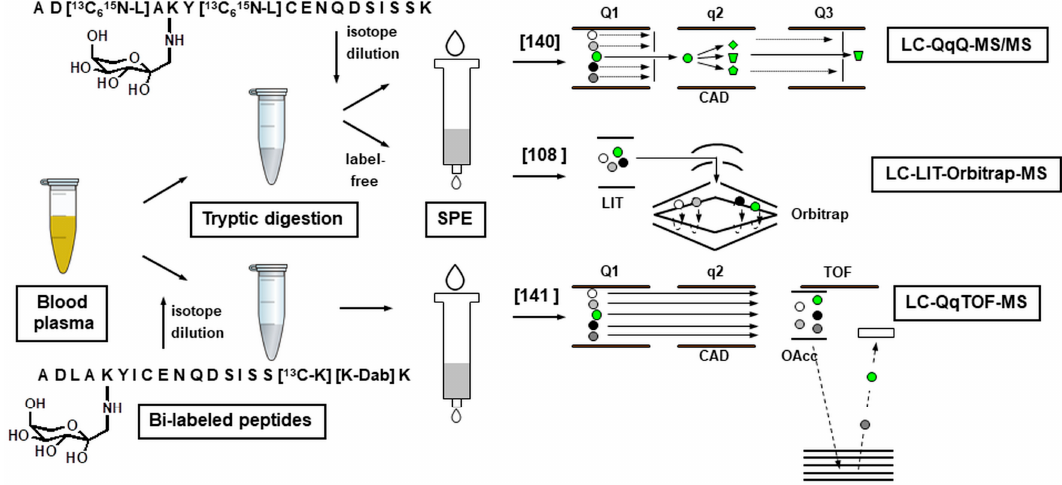
Figure 6. Quantification of individual protein glycation sites as Amadori-modified peptides in blood plasma tryptic digests by targeted and untargeted LC-MS approaches. LC-QqQ-MS/MS: green, white, black and grey circles are precursor ions, different shapes in green denote product ions; LC-LIT-Orbitrap-MS, LC-QqTOF-MS: green, white, black and grey circles denote quasi-molecular ions.